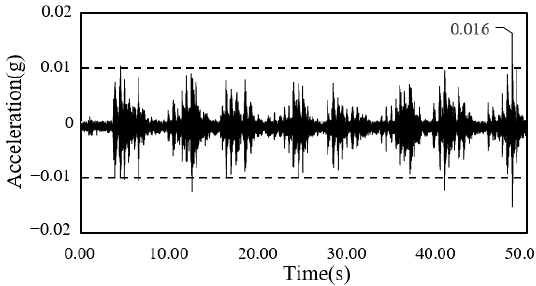
Figure 16. Time history of acceleration after framing completion (Sangsoo-dong building).